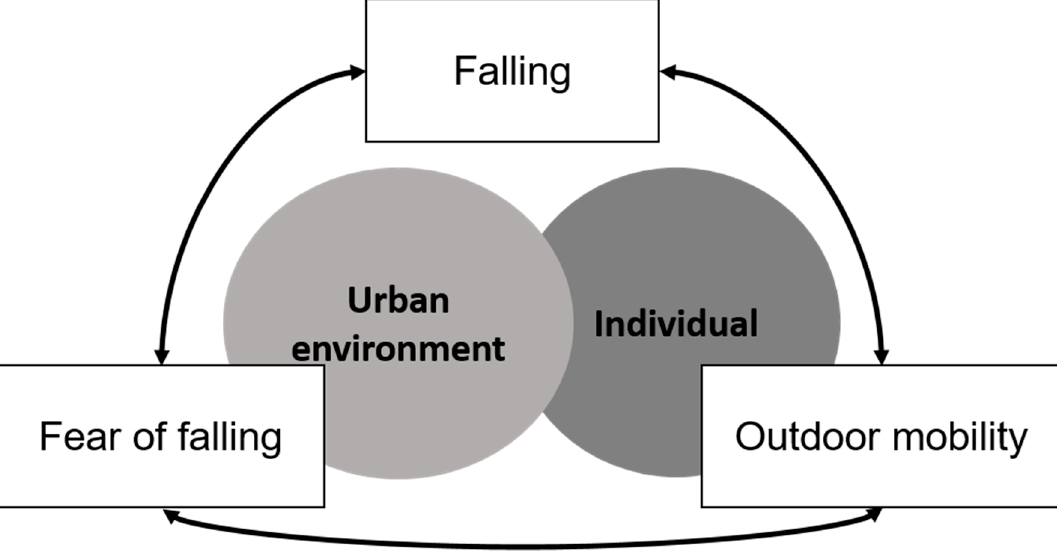
Figure 1. A proposed conceptual framework for exploring the relationships between fear of falling, falling and outdoor mobility, and the role of environmental and individual risk factors.